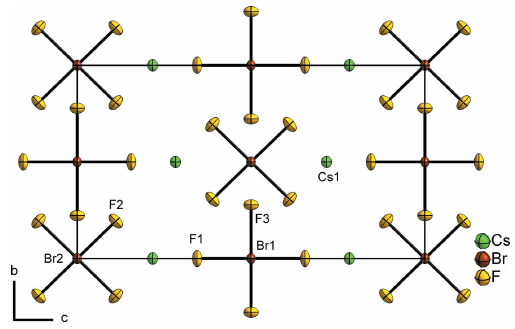
Figure 2 The crystal structure of CsBrF 4 in a projection along the a axis. Displacement ellipsoids are shown at the 70% probability level.